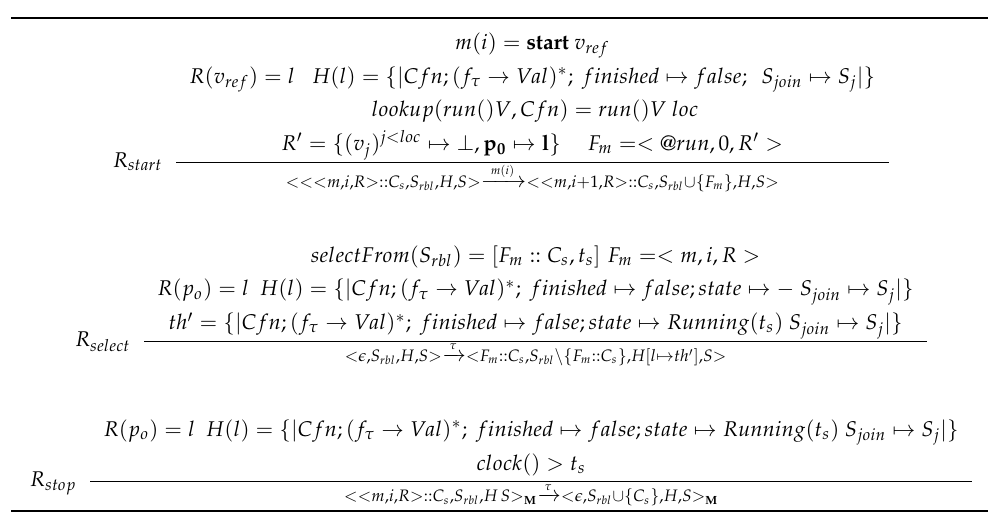
Table 8. Multi-threaded semantics: